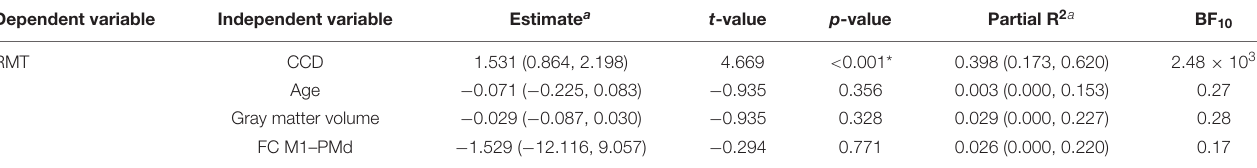
TABLE 2 | Multiple regression model for the dominant